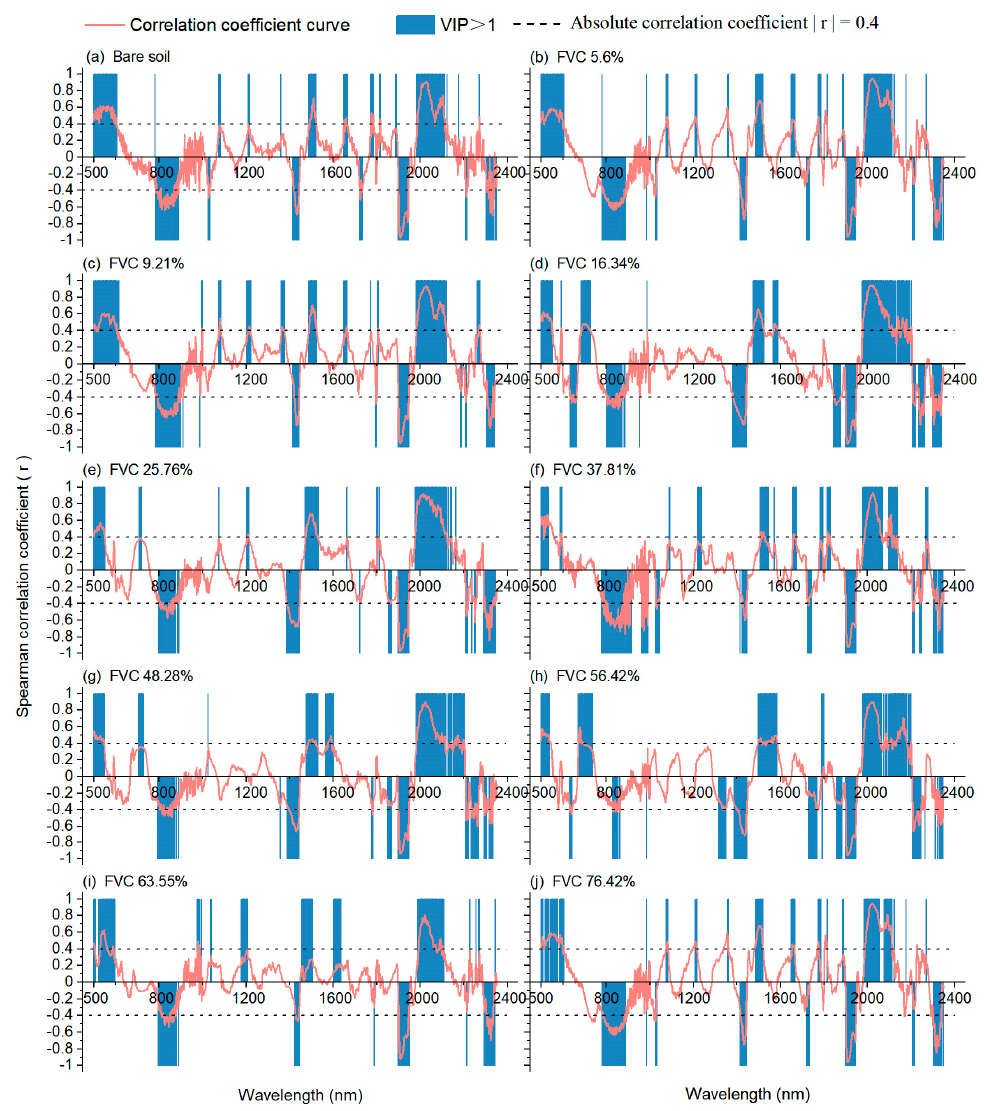
Figure 8. VIP scores in PLSR modeling (VIP > 1 is marked in gray) and Spearman correlation coefficient ( p < 0.01) between SSC and NMF-extracted soil